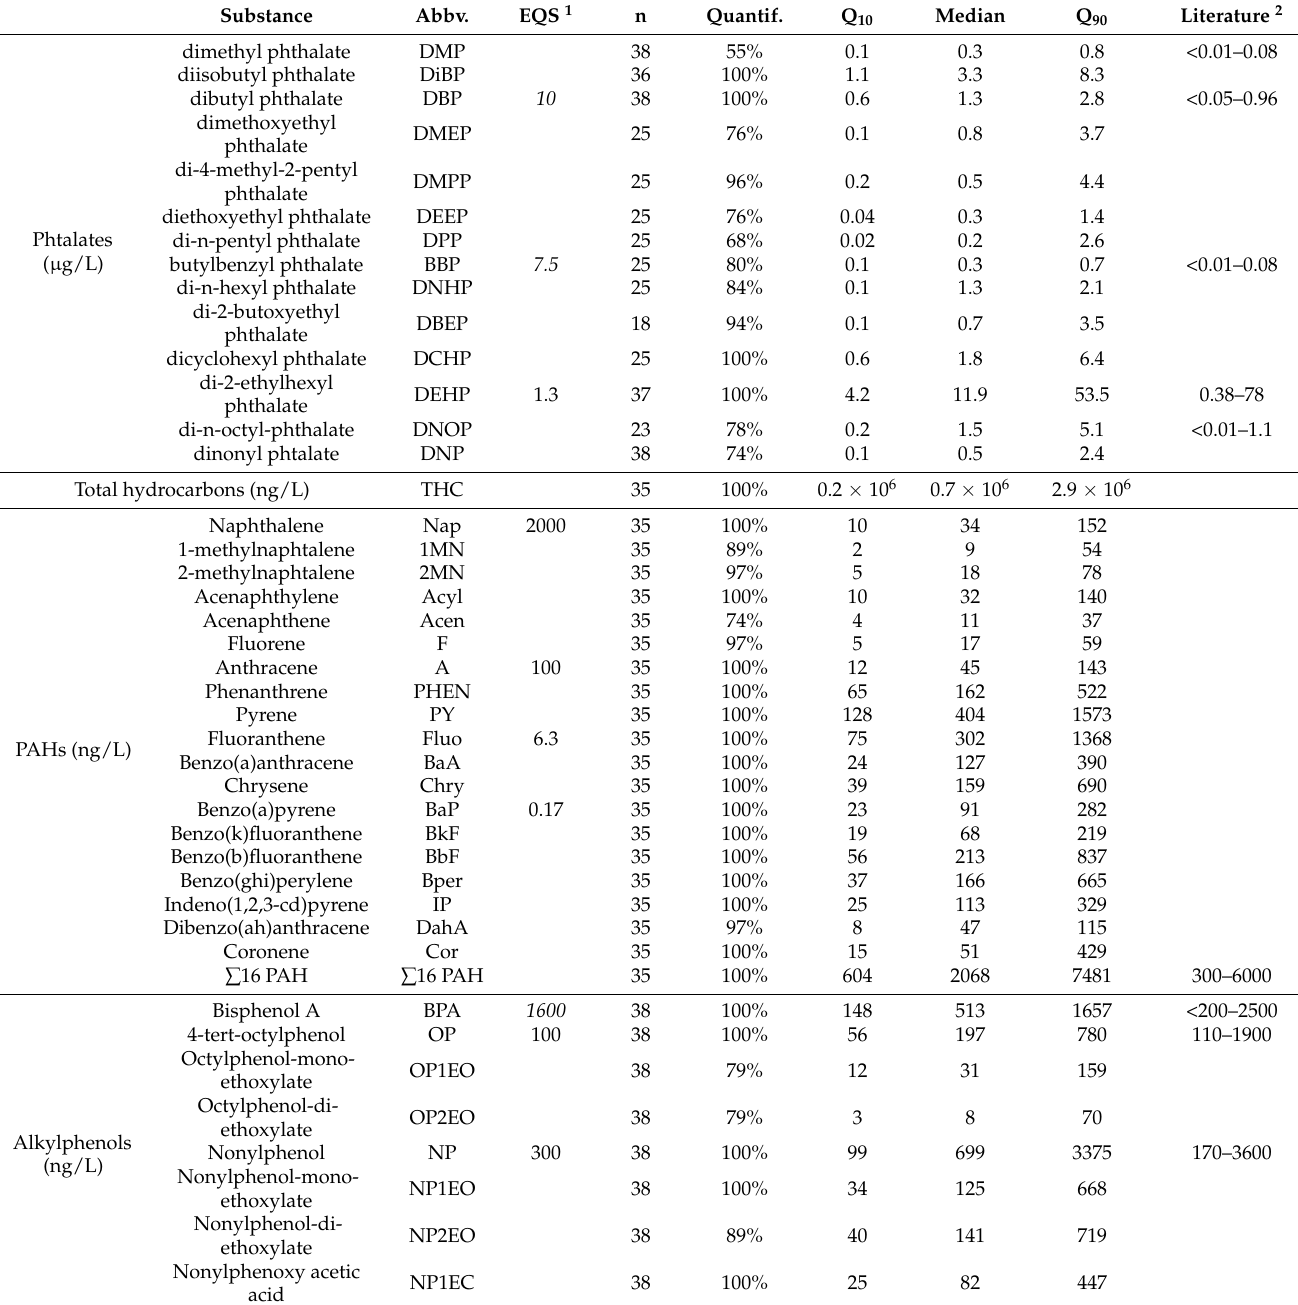
Table 6. Organic micropollutants (group 3) analyzed in the runoff, quantification frequency and range of quantified total EMC